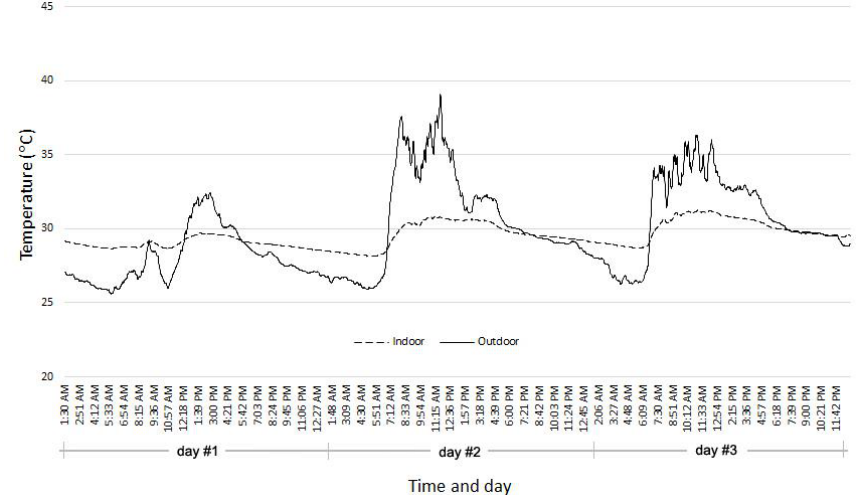
Fig. 14. Outdoors and indoors temperature recorded of C